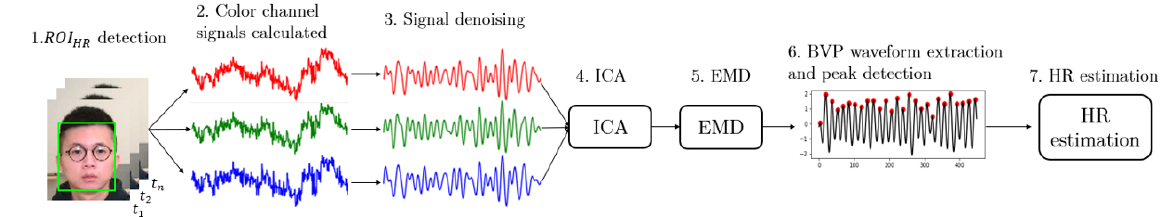
Figure 9. Methods developed for remote HR